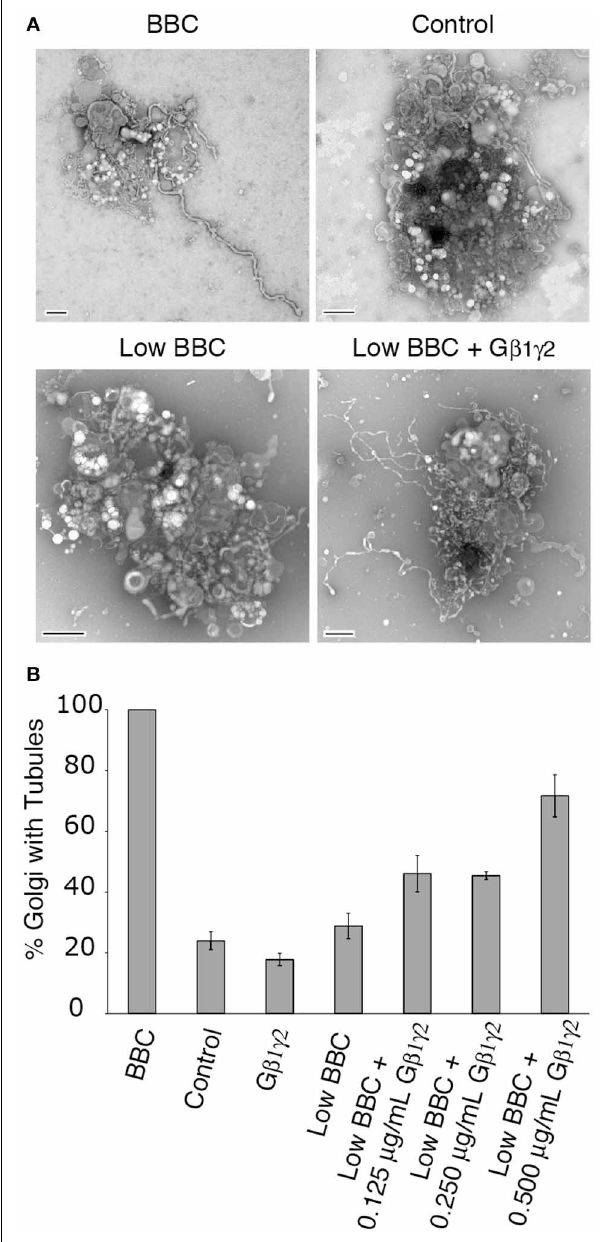
FIGURE 4 | G β 1 γ 2 stimulates cytosol-dependent Golgi membrane tubulation. (A) Representative EM micrographs of Golgi treated with BBC (1.5mg/ml), a BSA control (0.2mg/ml), Low BBC (0.15mg/ml), or Low BBC + G β 1 γ 2 (0.5 μ g/ml G βγ ). Each condition was in the presence of the G βγ buffer. Scale bar = 500nm. ( B ) Quantification of the percent of Golgi with membrane tubules, normalized to the maximum amount of tubulated Golgi with BBC (1.5mg/ml). G β 1 γ 2 purified protein alone does not stimulate Golgi membrane tubules above background levels (no BBC control). In the presence of low cytosol concentrations (Low BBC 0.15mg/ml), the addition of G β 1 γ 2 stimulates membrane tubules. Error bars = s.e.m. Low BBC + 0.0125 μ g/mL G β 1 γ 2 was statistically different than samples of Control, G β 1 γ 2 alone, or Low BBC, with p -values < 0.009 determined using